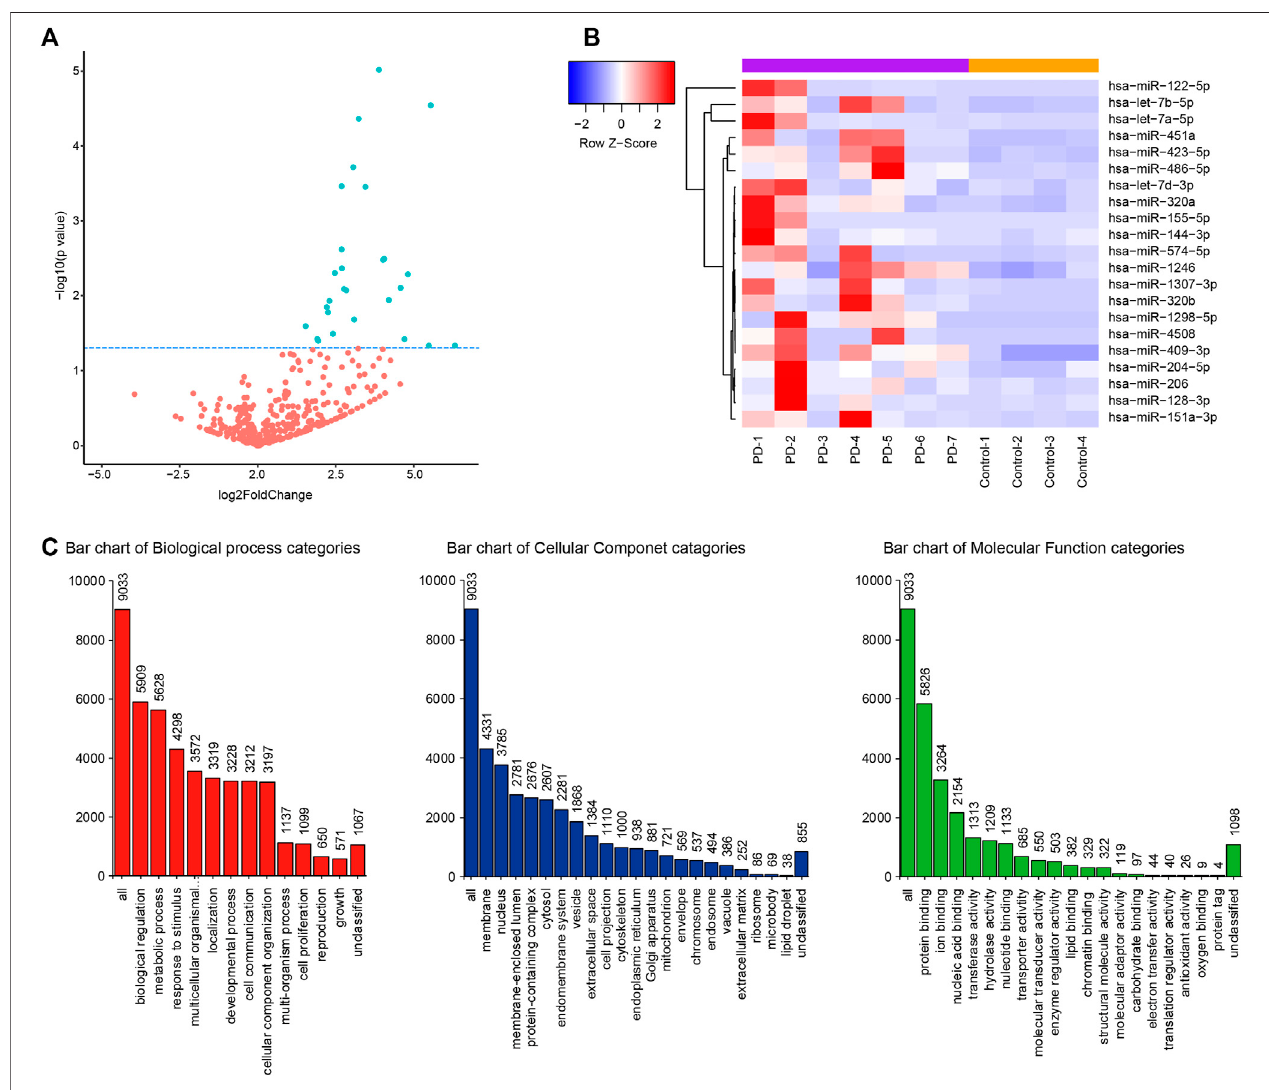
FIGURE 1 | CSF miRNA pro fi le data analysis and bioinformation prediction indicate the altered expression of miRNA in PD. (A) Volcano plot shows that most of altered CSF miRNAs were upregulated in PD patients compared to control group. Blue dots indicate a fold change expression > 1.5 [|log2 (Fold Change) | > 1] and p < 0.05 [ − log10 ( p value) > 1.3] (B) . Heatmap represents the mean fold change in PD and related differential miRNA signature. Each entry of the grid refers to relative fold (log2) between the expression level ofa given miRNA in all participators. The color ofeach entry represents the abundance of miRNAs, ranging from blue (negative values) to red (positive values). (C) . GO enrichment analysis of predictive target genes of 21 different miRNAs in CSF between PD patients and control